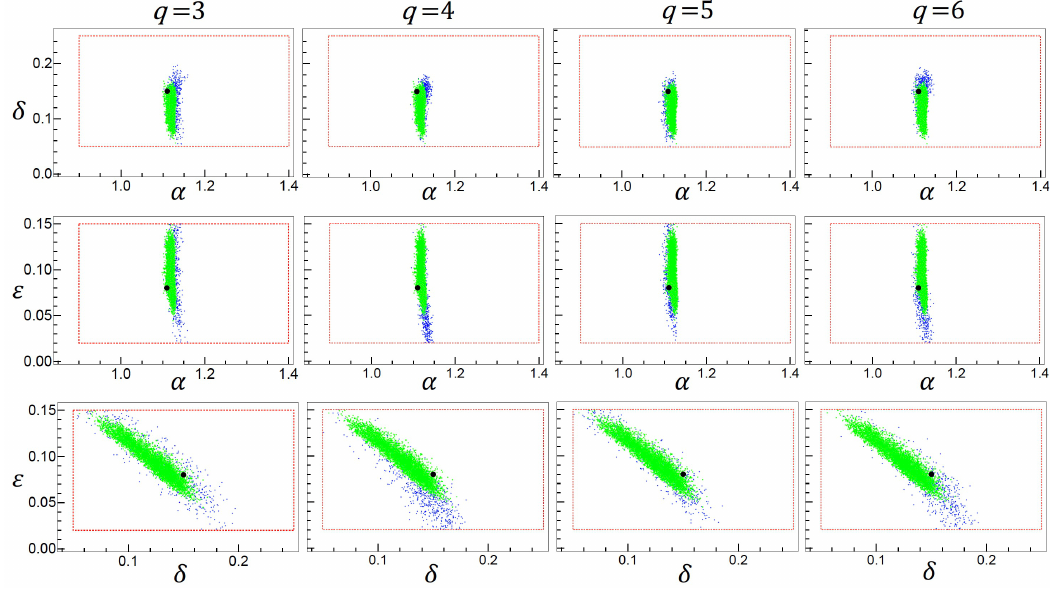
Figure 10: Analogously to Fig.9, the exact posteriors for model (13) (green) are compared against ABC posteriors (blue) from